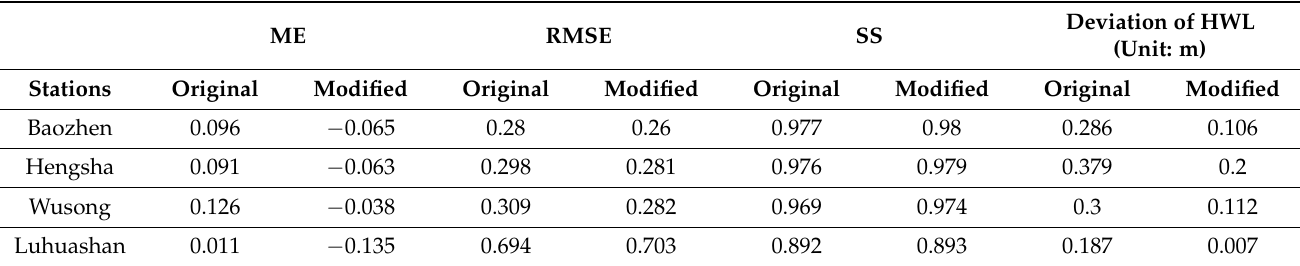
Table 4. Statistics of errors in measured and simulated water levels before and after application of the modified